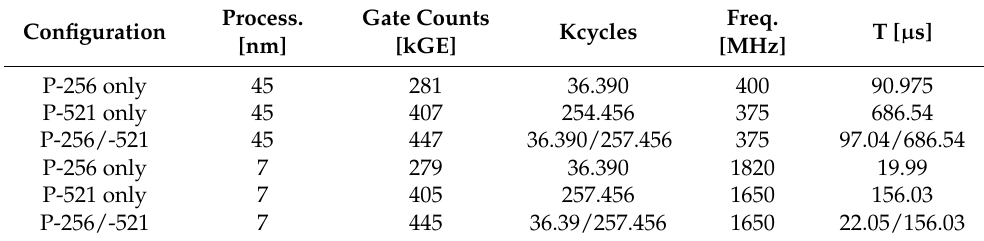
Table 4. Synthesis Results on ASIC Technologies.